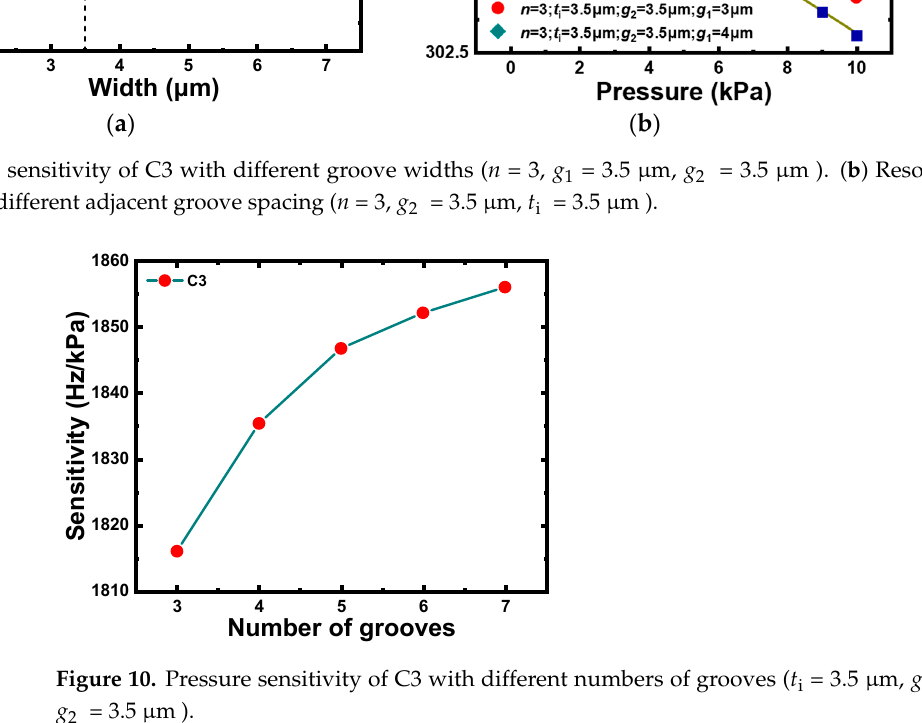
Figure 9. ( a ) Pressure sensitivity of C3 with different groove widths ( n = 3, 𝑔 (cid:2869) = 3.5 μm , 𝑔 (cid:2870) = 3.5 μm ). ( b ) Resonance frequency of C3 with different adjacent groove spacing ( n = 3, 𝑔 (cid:2870) = 3.5 μm , 𝑡 (cid:2919) = 3.5 μm ).